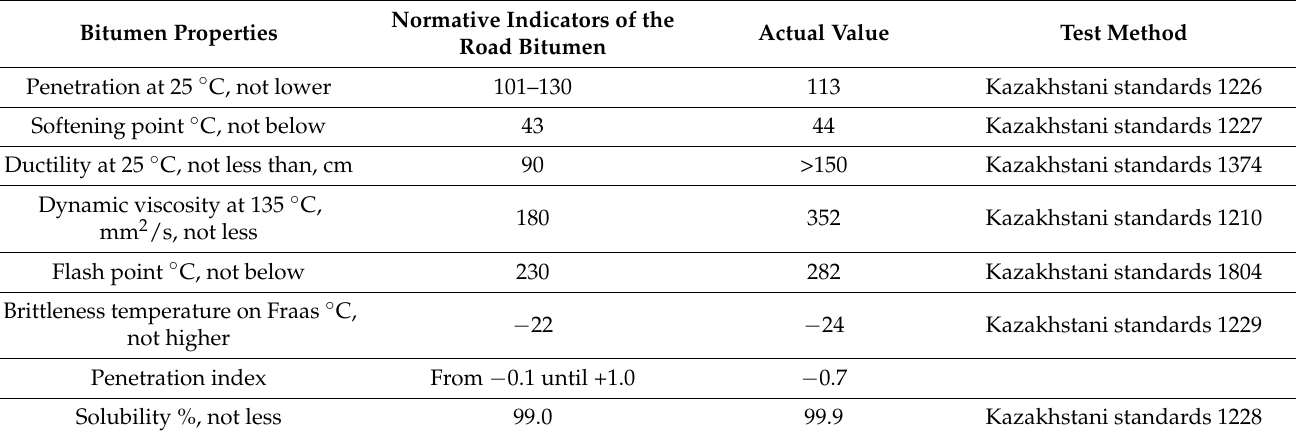
Table 2. Characteristics of road bitumen 100/130.